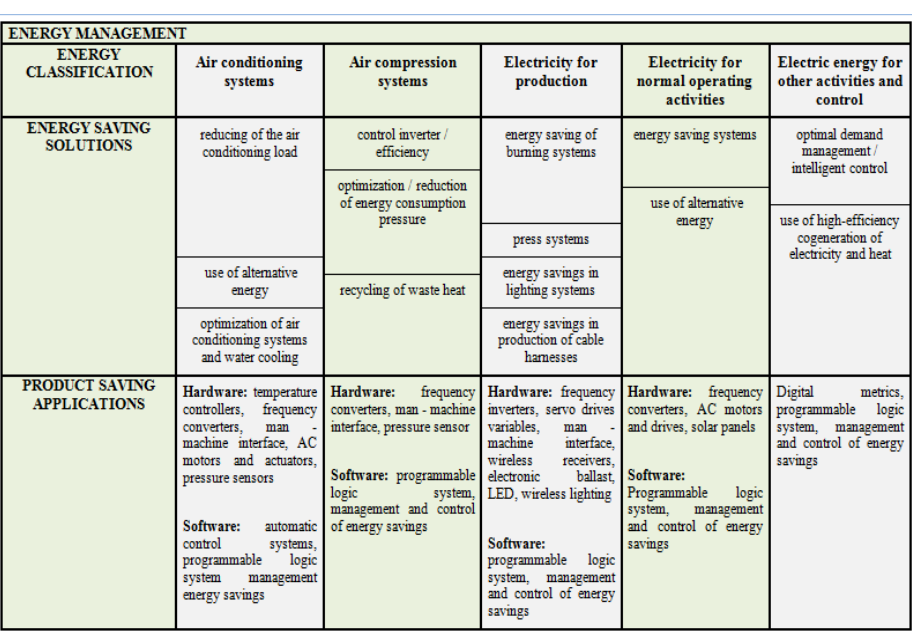
Table 1 – Types of energy use and energy-saving